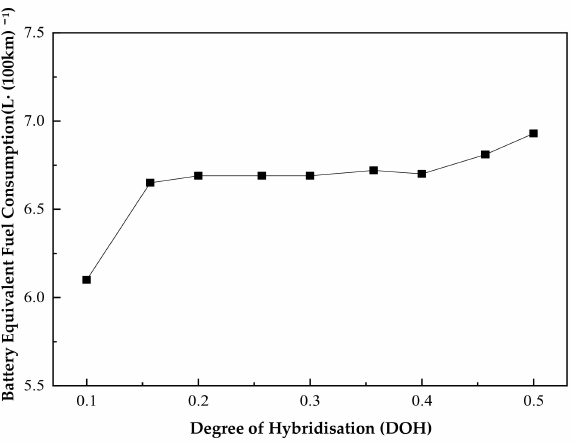
Figure 15. Curves of the engine fuel consumption with DOH.